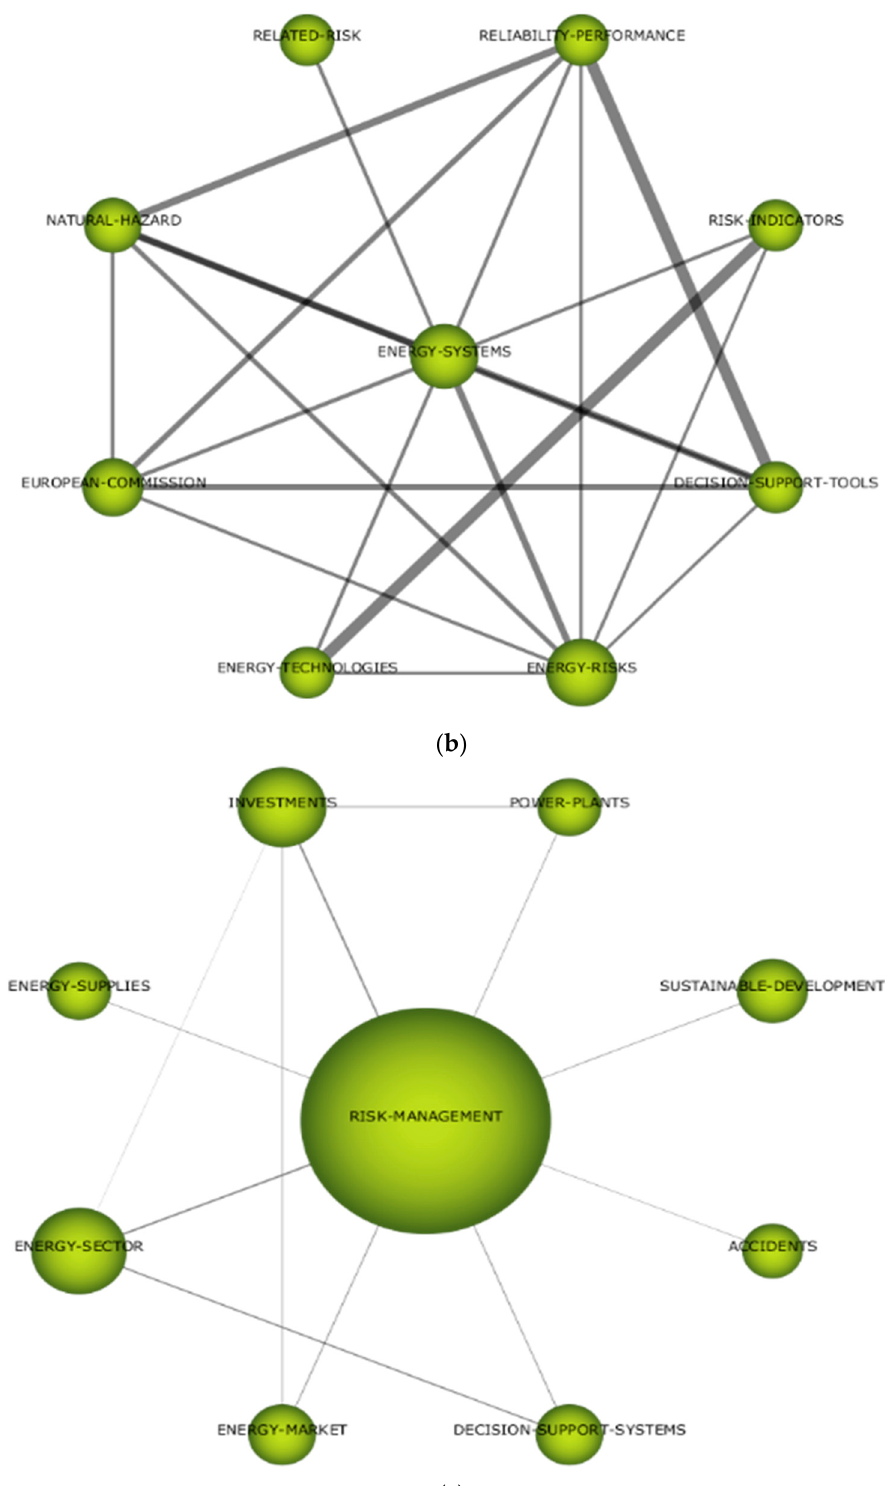
Figure 6. Major theme ( a ) and thematic network ( b , c ) of the second sub-period (2004–2010). Note: Clusters information: ENERGY-SYSTEMS (centrality: 63.67; density: 107.74); RISK-MANAGEMENT (centrality: 66.9; density: 12.16); DEVELOPING-COUNTRIES (centrality: 0.7; density: 50); ENVIRONMENTAL-IMPACT (centrality: 1.05; density: 50). Node size is proportional to the number of papers; the number in a node denotes the number of papers related to a node topic. See Section 2.2 for description of the quadrants.